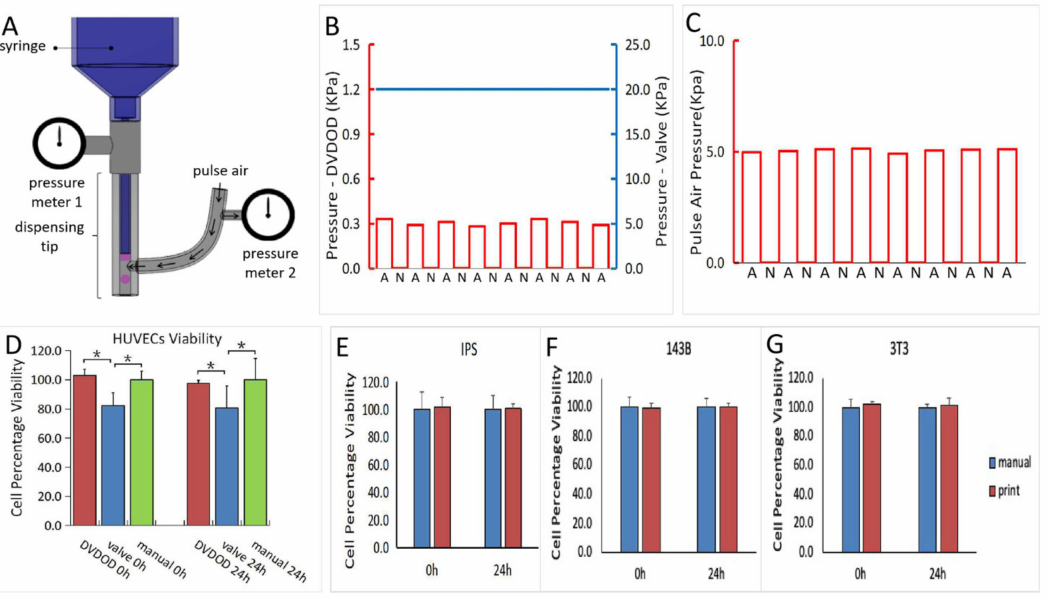
Figure 3. ( A ) Illustration of the pressure measurement set-up in the DVDOD. ( B ) The plots of pressure measured from the syringes of the DVDOD (red, A: syringe-moving is activated, N: syringe-moving is not activated) and valve-based printing technology (blue). ( C ) The plot of the pressure measured from the pulsed air in the DVDOD. ( D ) Cell percentage viability of HUVECs in the DVDOD, valve-based technology, and the manual operation at 0 h and 24 h. All the values were normalized to those of manual operation. * represents significant di ff erence ( p < 0.05 ) . ( E )– G ) The cell percentage viabilities of Induced Pluripotent Stem (IPS), 143B, and MC3T3-E1 cells at 0 h and 24 h after bioprinting using DVDOD. All the values were normalized to those of manual operation. There was no significant di ff erence observed in any cell type between the DVDOD and manual